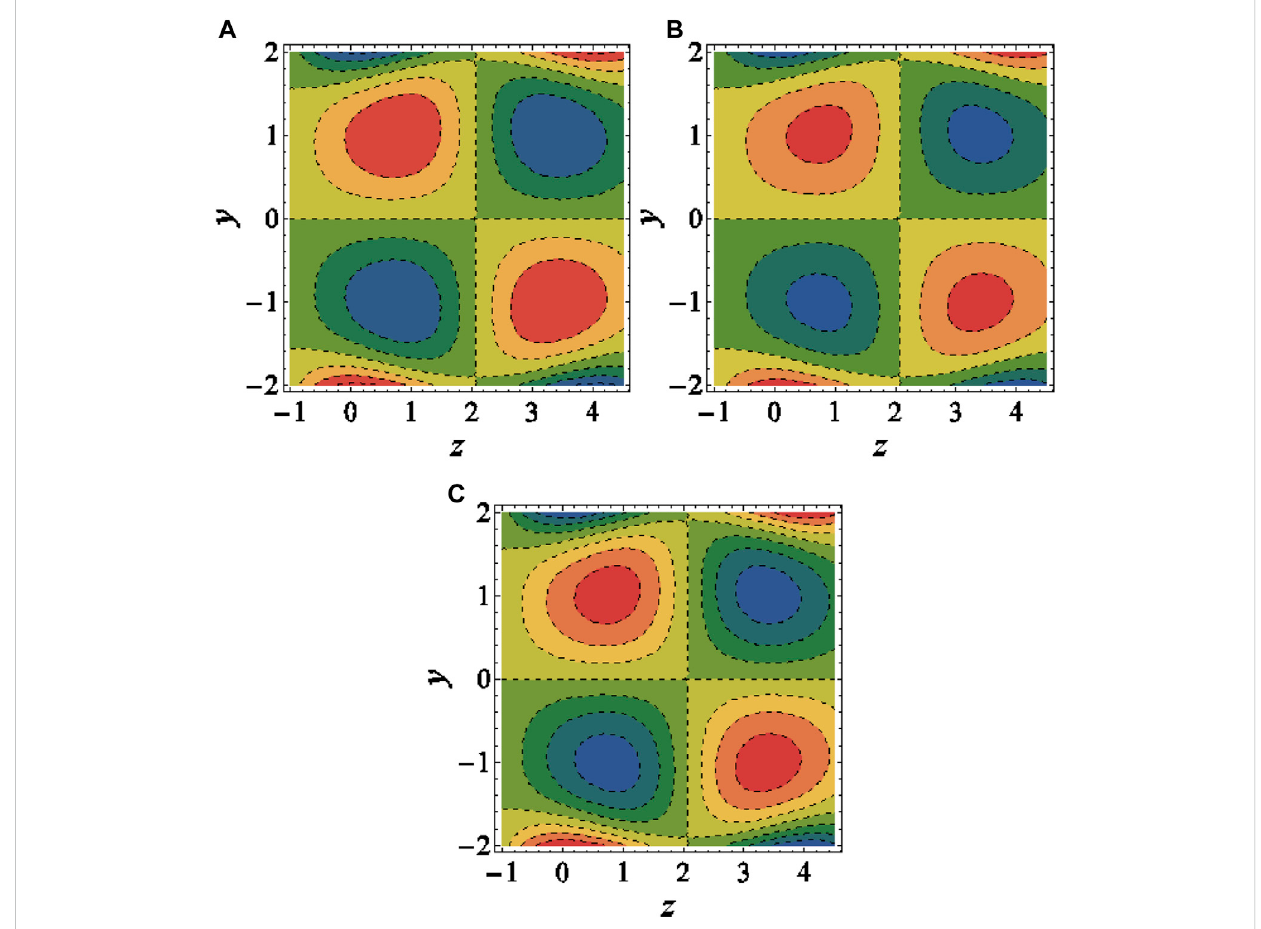
FIGURE 11 (A – C) Flow pattern for E